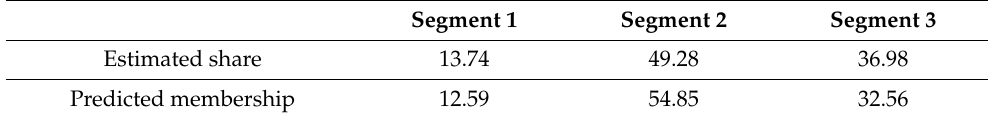
Table 7. Market size of each